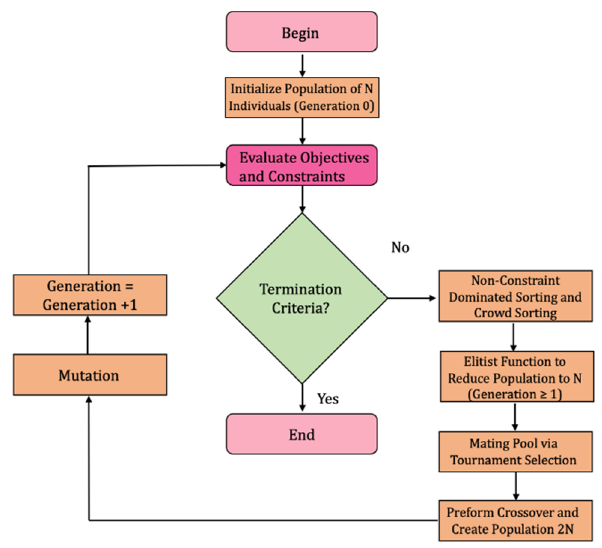
Figure 1. NSGA II Flowchart .